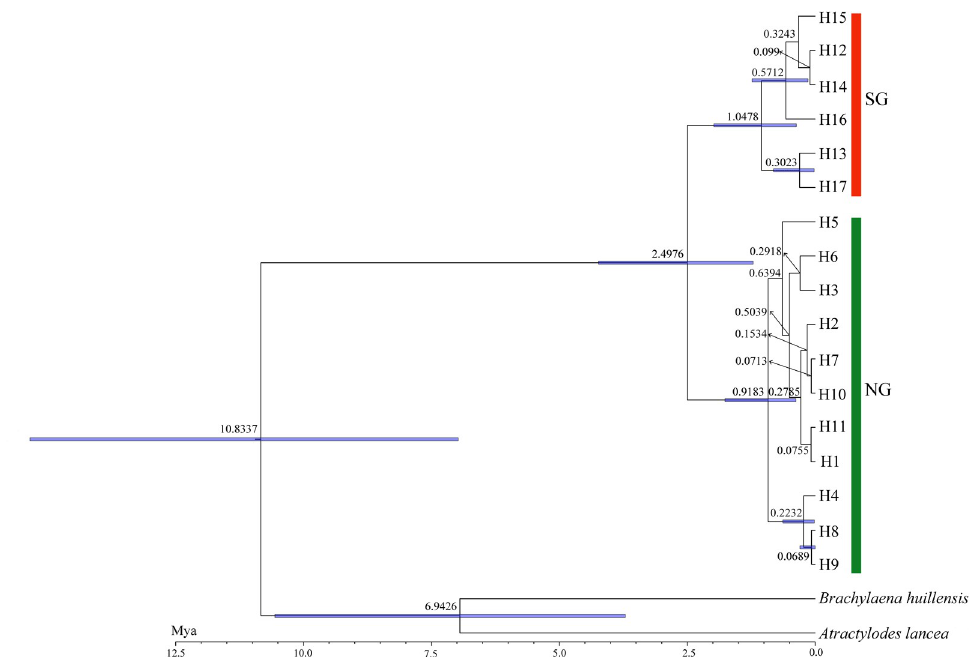
Fig 4. The divergence time (Mya) of 17 cpDNA haplotypes of the northern group (NG) and southern group (SG) of Tugarinovia mongolica based on BEAST